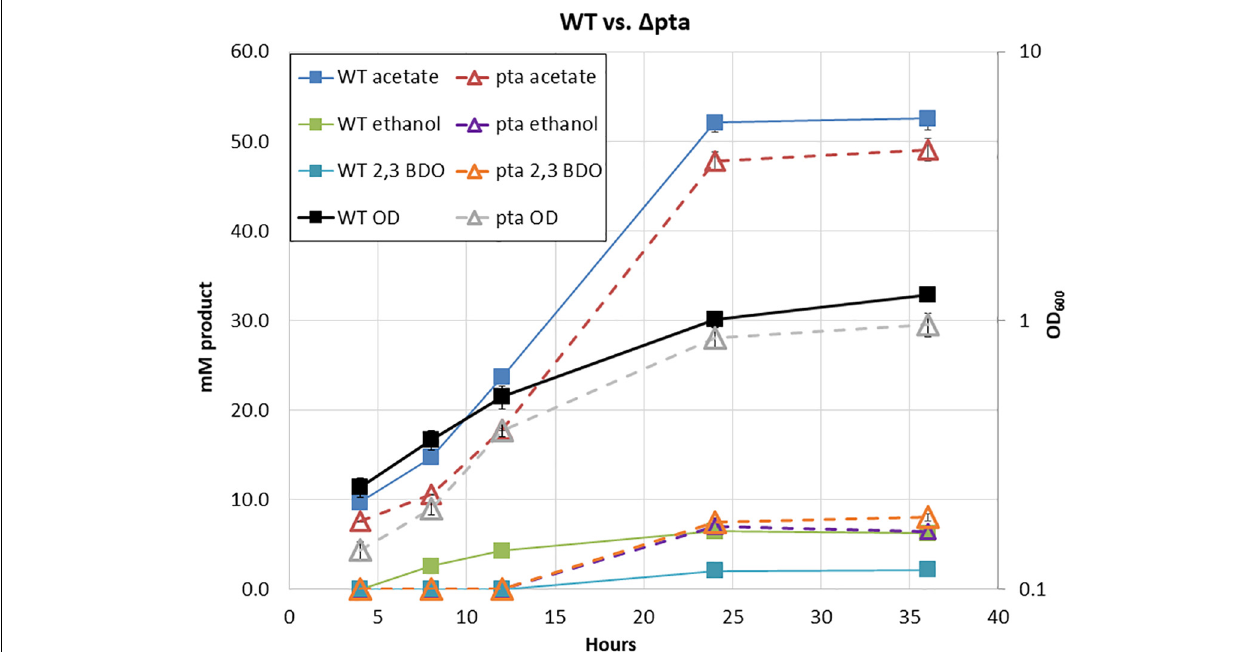
FIGURE 2 | Heterotrophic growth and fermentation products of C. ljungdahlii wild type and the pta deletion strain on PETC with 5 g/L fructose. Wild type is marked with solid lines and squares, while (cid:49) pta is marked dashed lines with hollow triangles. Growth rate, OD 600 , and fermentation products are similar across the duration of the experiment.